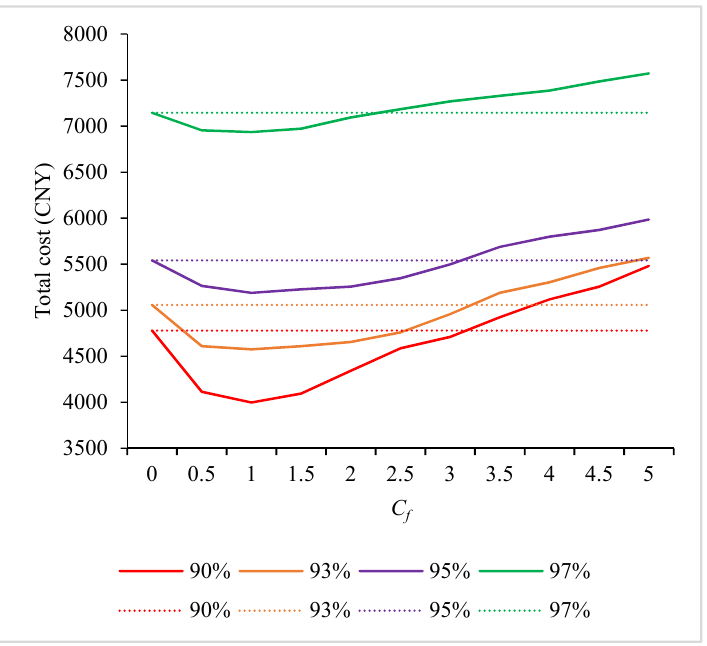
Figure 3. Variation in total cost with C f under different freshness constraints.